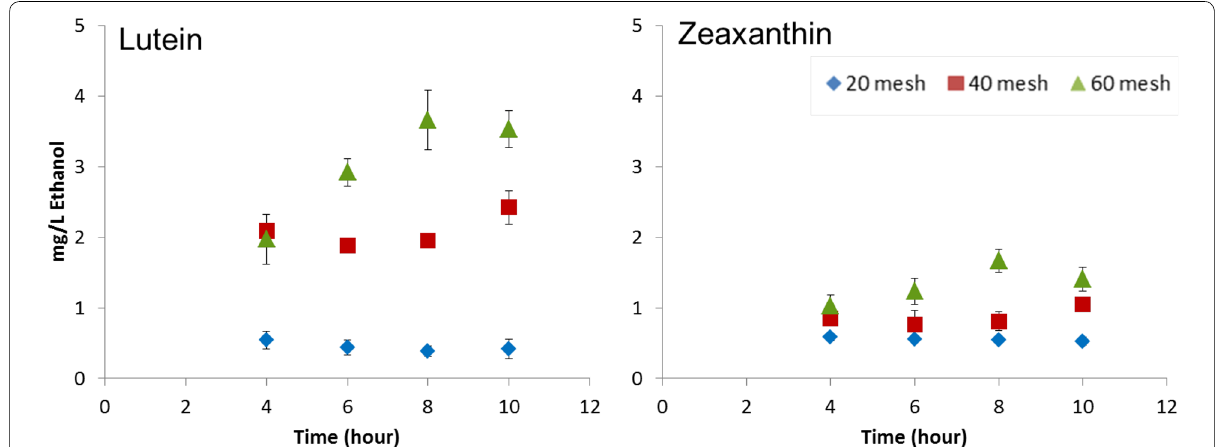
Fig. 1 Soxhlet extraction of DDGS with particle size ranging from 20 to 60 mesh. Both lutein and zeaxanthin were optimally extracted at the smallest particle size. Therefore, 60 mesh was chosen for subsequent experiments